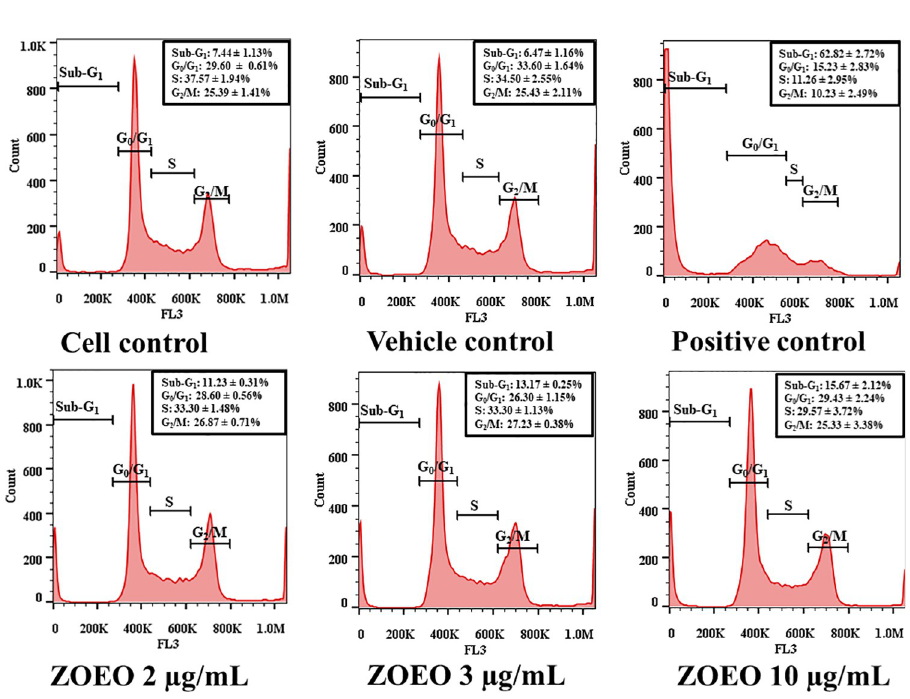
Fig 3. Cell cycle distribution of MCF-7 after 48 h exposed to various concentrations of ZOEO in comparison with the controls. Sub sub-G1 peaks are indicated by red arrows. The dataset is available in S6 Table.